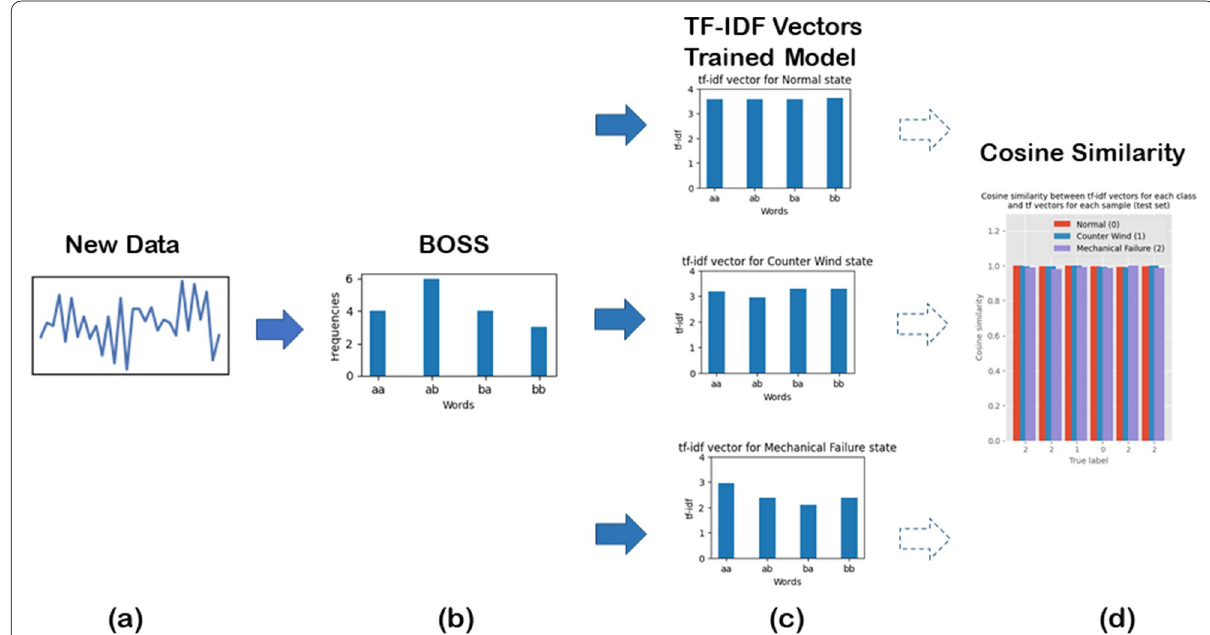
Fig. 7 Schematic diagram of classification with the cosine similarity: a New data for query is first transformed into SFA words, b the SFA words of the new data is transformed into the BOSS histogram, c the trained model in the form of tf‑idf algorithm is given, and d the classification is carried out through calculating the cosine similarity between the trained model and the